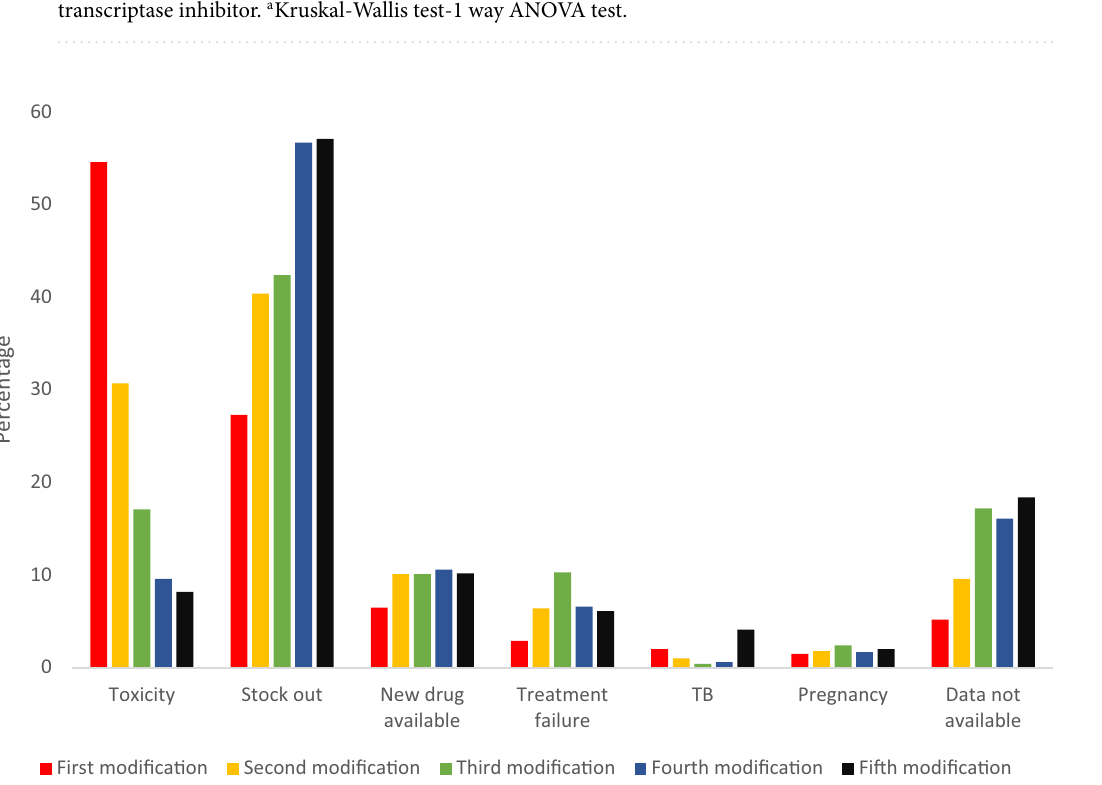
Figure 3. Distribution of documented reasons for cART regimen modification among PLWHA in hospitals of Asmara, 2005–2021. The percentages represent the proportion of the documented reason of modification within the order of the